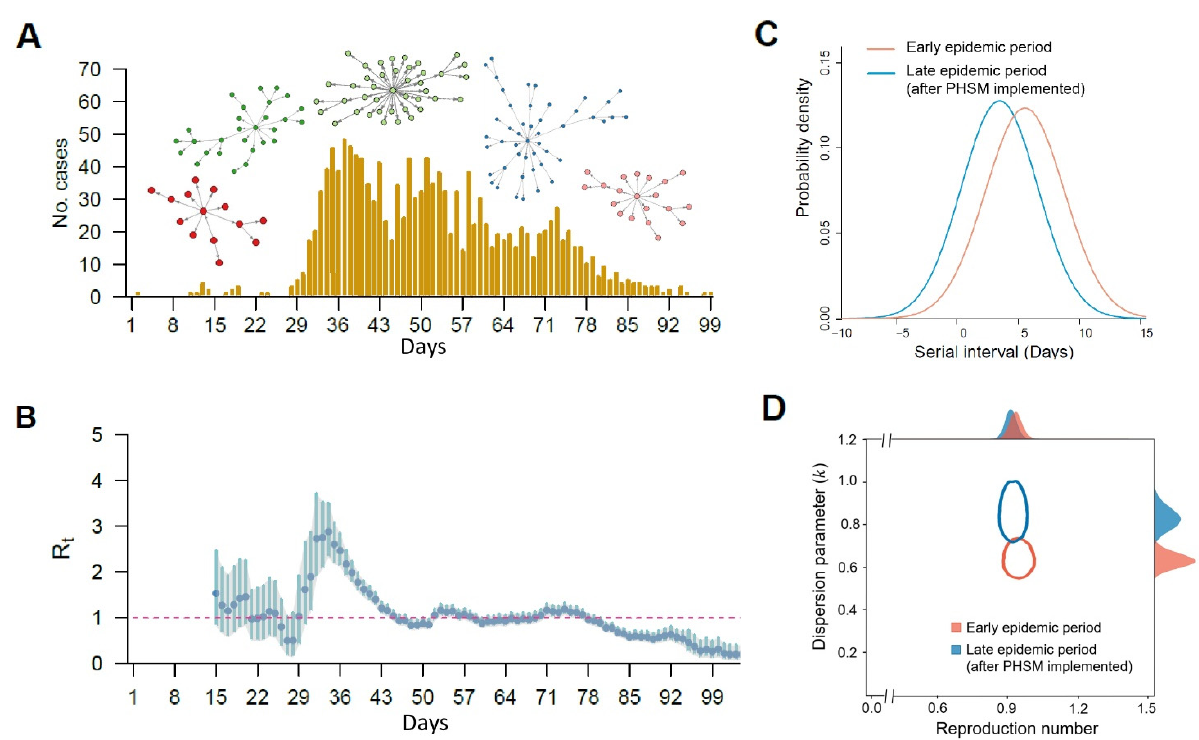
Figure 2. Epidemiological parameters to assess the impact of public health and social measures. ( A ) Epidemic curve with the transmission chain of the infectious diseases (a measure of transmission activity). ( B ) Daily effective reproductive number ( R t ) of the infectious diseases (a measure of transmissibility). ( C ) Serial interval distribution of the infectious diseases in two different epidemic periods. ( D ) Risk for superspreading events for infectious diseases during two different epidemic periods. Note: presented here are the outcomes of COVID-19 in South Korea, modified from [13,14].